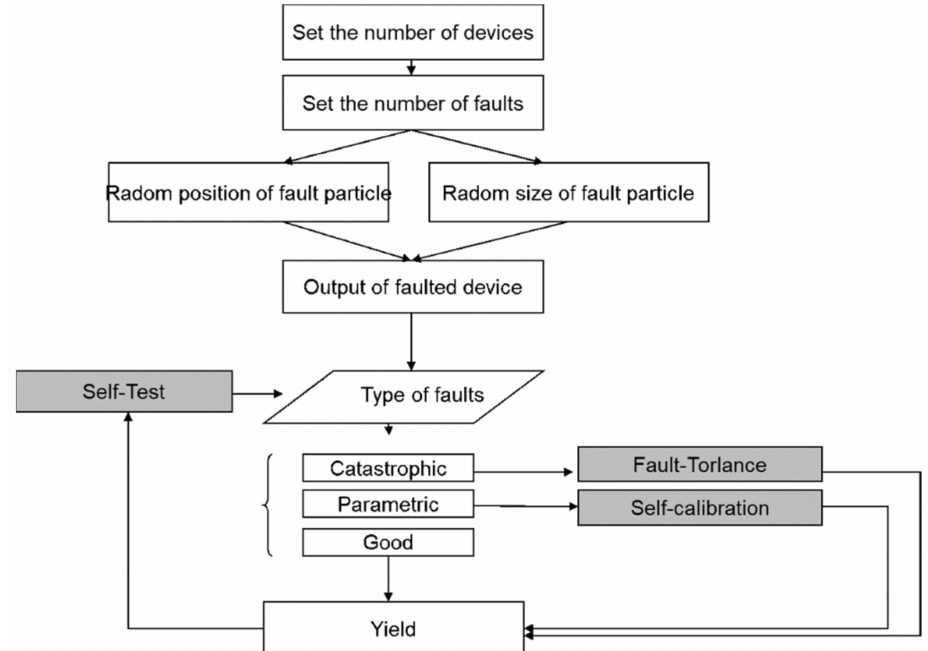
Figure 10. Flowchart of self-test, self-calibration and fault-repair model.